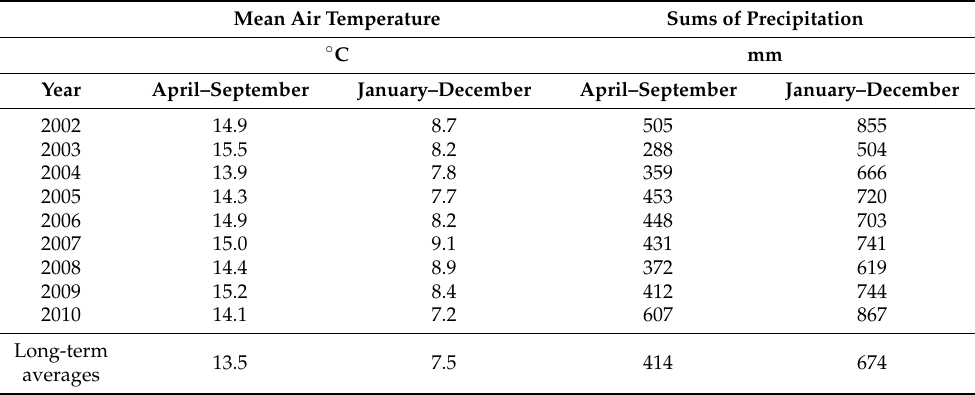
Table A8. Mean air temperature ( ◦ C) and sums of precipitation (mm) in years 2002–2010 in the